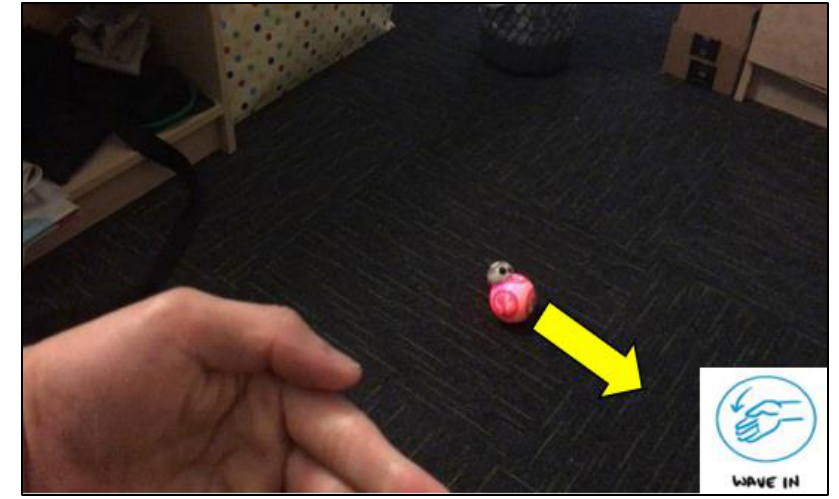
Figure 7. Wave In gesture activates RightMotion of the robot